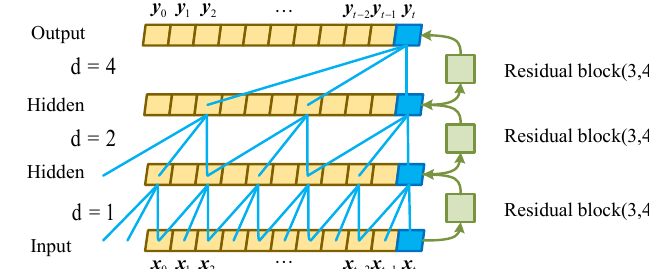
Figure 3. The Structure of the TCN Model.